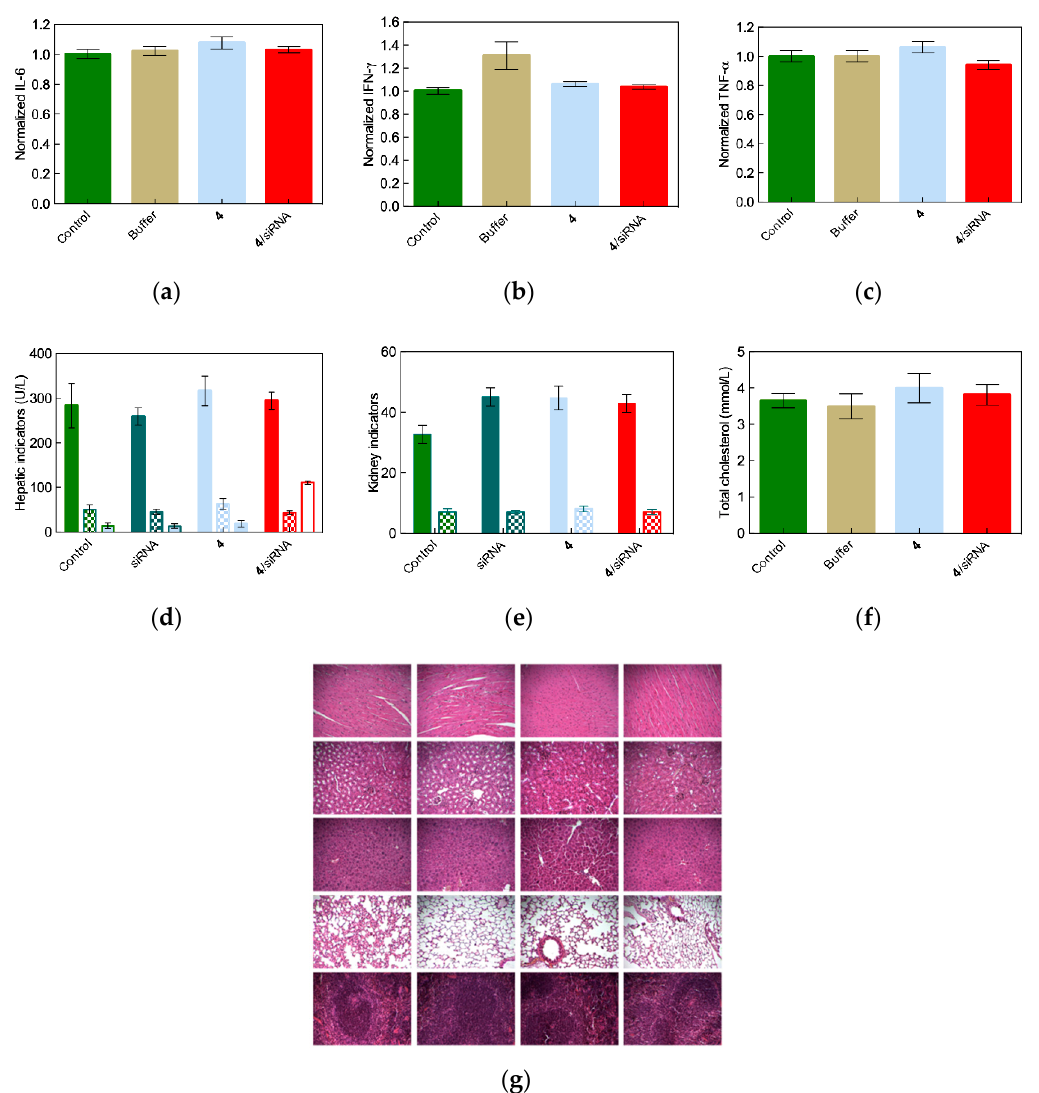
Figure 8. In vivo levels of inflammatory cytokines interleukine-6 (IL-6, a ), interferon-gamma (INF- γ , b ), and tumor necrosis factor-alpha (TNF- α , c ), observed in male C57BL/6 mice treated with 4 and its siRNA complex (3.0 mg/kg siRNA, N/P = 5) by intravenous injection. Non-treated mice and animals treated with buffer solutions were used for control. Mice were sacrificed 24 h after treatment and the ELISA assay was performed on the collected serum. ( d ) Hepatic enzyme levels (aspartic aminotransferase AST (solid bars), alanine transferase ALT (patterned bars), gamma-glutamine transferase γ -GLT (empty bars), ( e ) kidney functions (creatinine CRE (mmol/L, solid bars), blood urea nitrogen BUN ( μ mol/L, patterned bars), and ( f ) cholesterol level in the blood measured in the treated mice after sacrifice. ( g ) Pathology of major organs from treated mice (HES staining). Columns (from left to right): Control, 4 , 4 /siRNA, and 4 /scrambled siRNA. Rows (from top to bottom): Heart, kidney, liver, lung, spleen. Adapted from [7] with the permission of John Wiley and Sons, 2016.